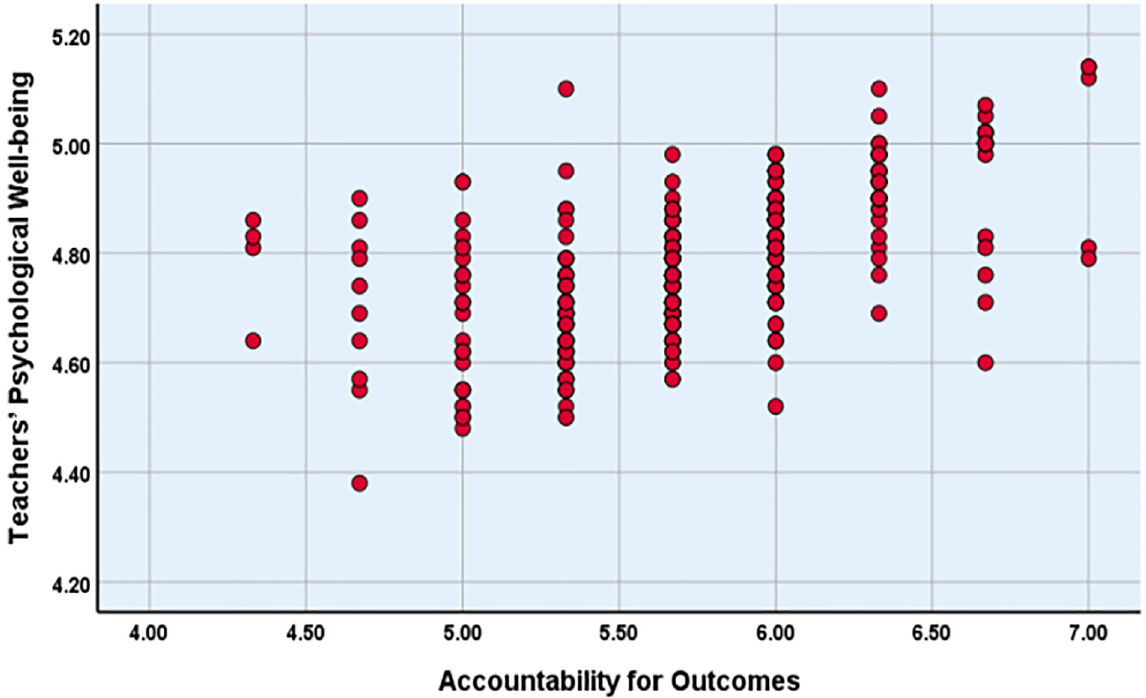
Fig 4. Pearson’s product-moment correlation between accountability for outcomes and teachers’ psychological well-being. The scatterplot clearly shows the significant positive relationship between accountability for outcomes (subdomain of leadership empowering behaviour) and teachers’ psychological well-being at secondary